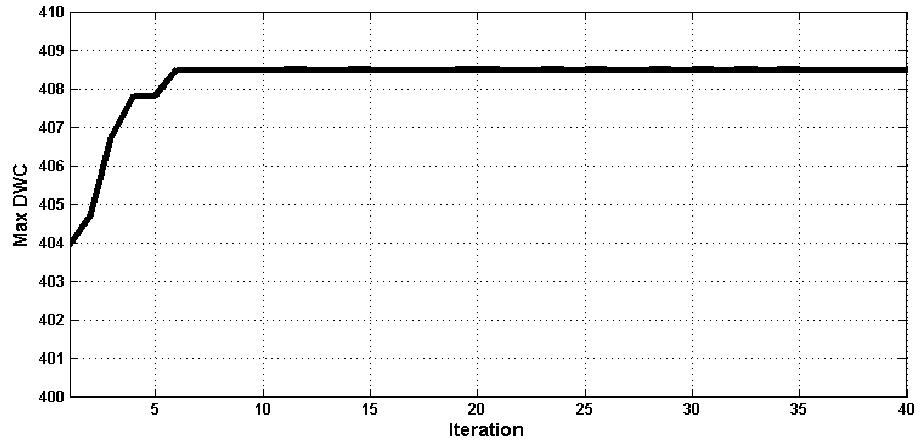
Figure 4. Allowable dynamic wrench capability versus iteration number for base point locations being displaced equidistantly.